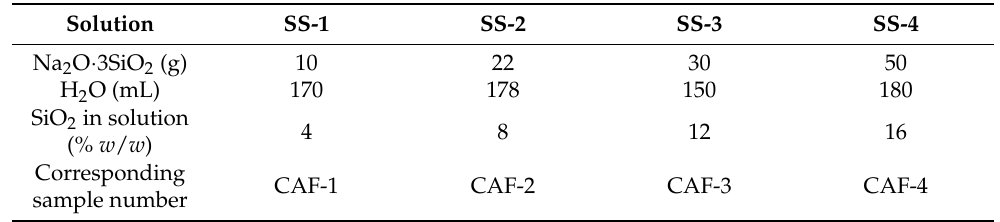
Table 3. Sodium silicate solution of different concentrations formed by sodium silicate powder and deionized